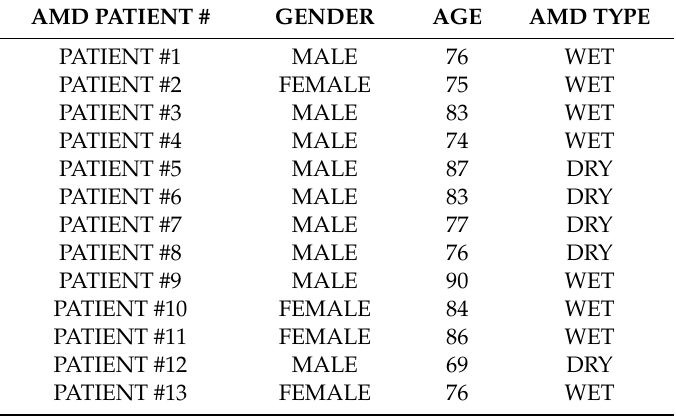
Table 1. Age-related macular degeneration (AMD) patients’ and AMD retinal pigment epithelial (RPE) cell lines’